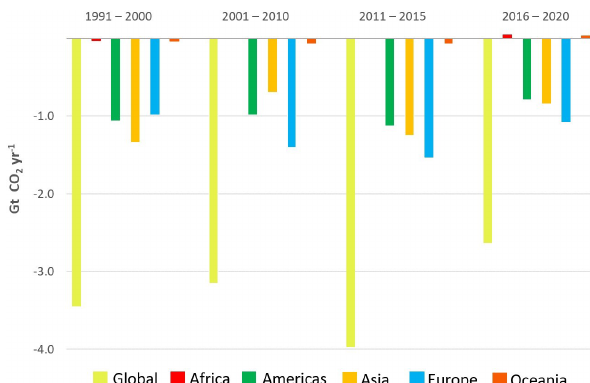
Figure 3. Estimates of the emissions/removals on forest land (FL) based on FRA 2020 for global (acid green) and regional totals (Africa: red; Americas: green; Asia: gold; Europe: sapphire; Ocea- nia: orange) in GtCO 2 yr − 1